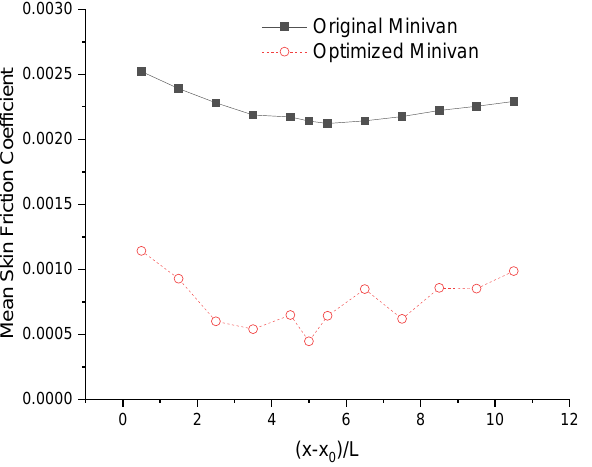
Figure 13. Mean skin friction coefficient comparison of original minivan and optimized minivan.